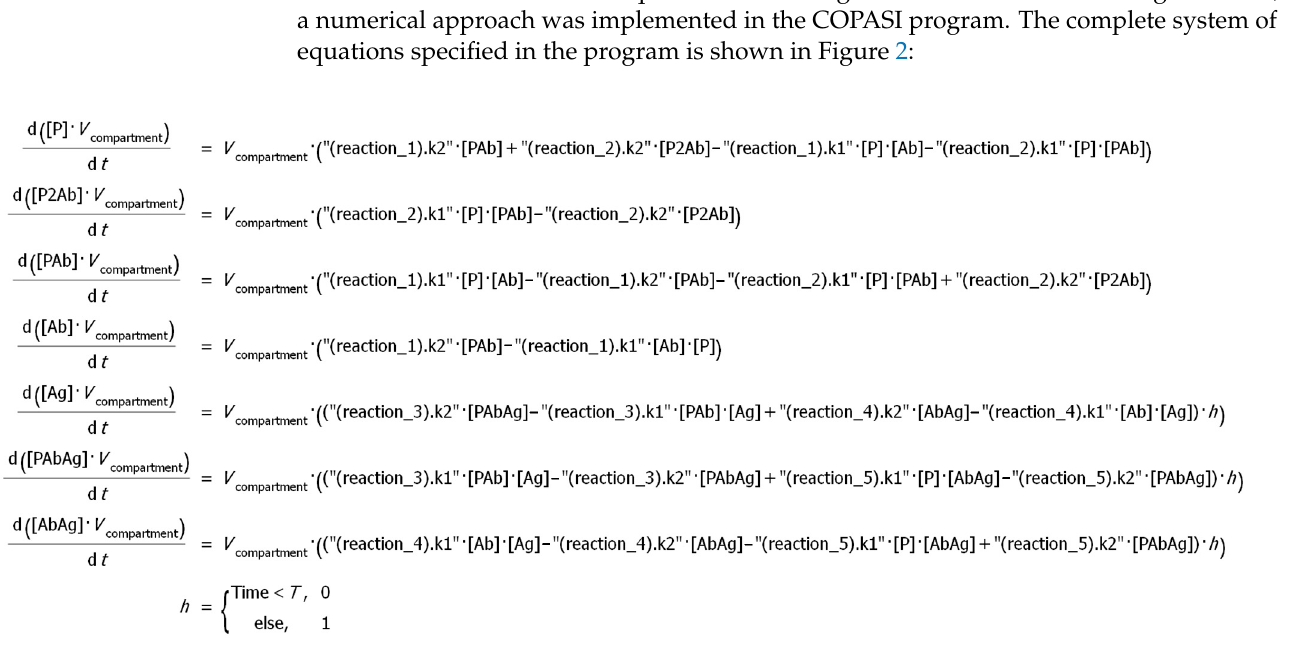
Figure 2. The system of differential equations describing the serodiagnostic lateral flow system with two antigens. k1— kinetic constants of association of the corresponding reaction, k2—kinetic constants of dissociation of the corresponding reaction, h —Heaviside function.